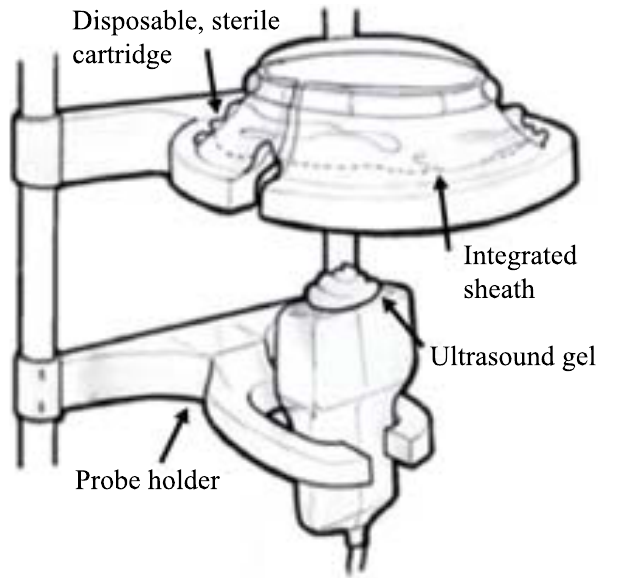
Figure 2. Design concept sketch.